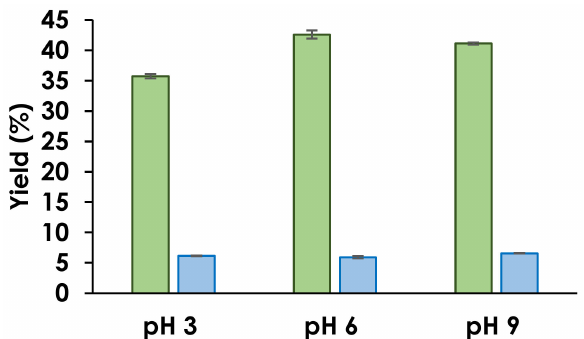
Figure 1. Extraction yield of propolis extracts using ethanol (green bar) and water (blue bar) as solvents at di ff erent pH